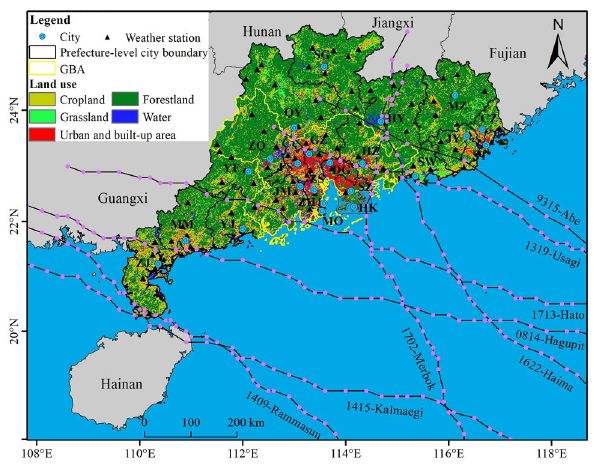
Fig. 1 Land use and 21 prefecture-level cities in Guangdong Prov- ince, China and the tracks of 8 tropical cyclone (TC) events used in model validation and demonstration—Abe (9315), Hagupit (0814), Usagi (1319), Rammasun (1409), Kalmaegi (1415), Haima (1622), Merbok (1702) and Hato (1713). The number in the parentheses is the ID of the TC in the China Meteorological Administration dataset and the first two numbers represent the year of TC genesis. The two capital letters represent the 21 prefecture-level cities and two regions from the south to the north—ZJ: Zhanjiang, MM: Maoming,